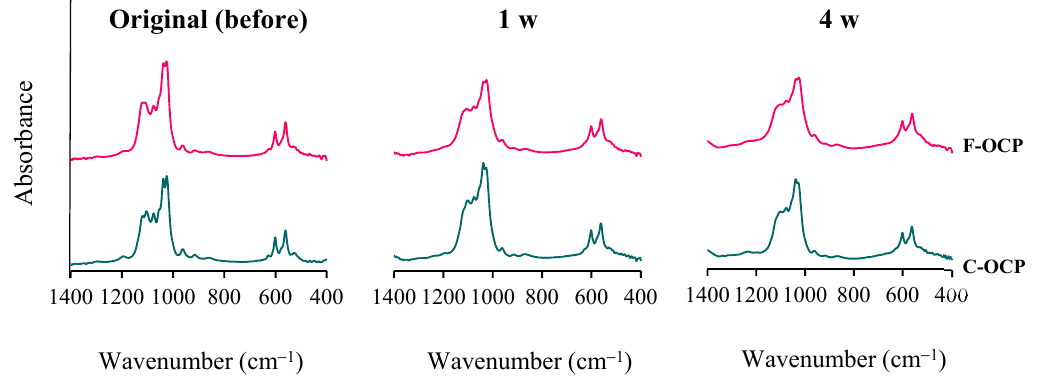
Figure 4. Changes in the FTIR spectra of F-OCP and C-OCP at the original (before), 1 week, and 4 weeks after implantation of rat abdominal regions.